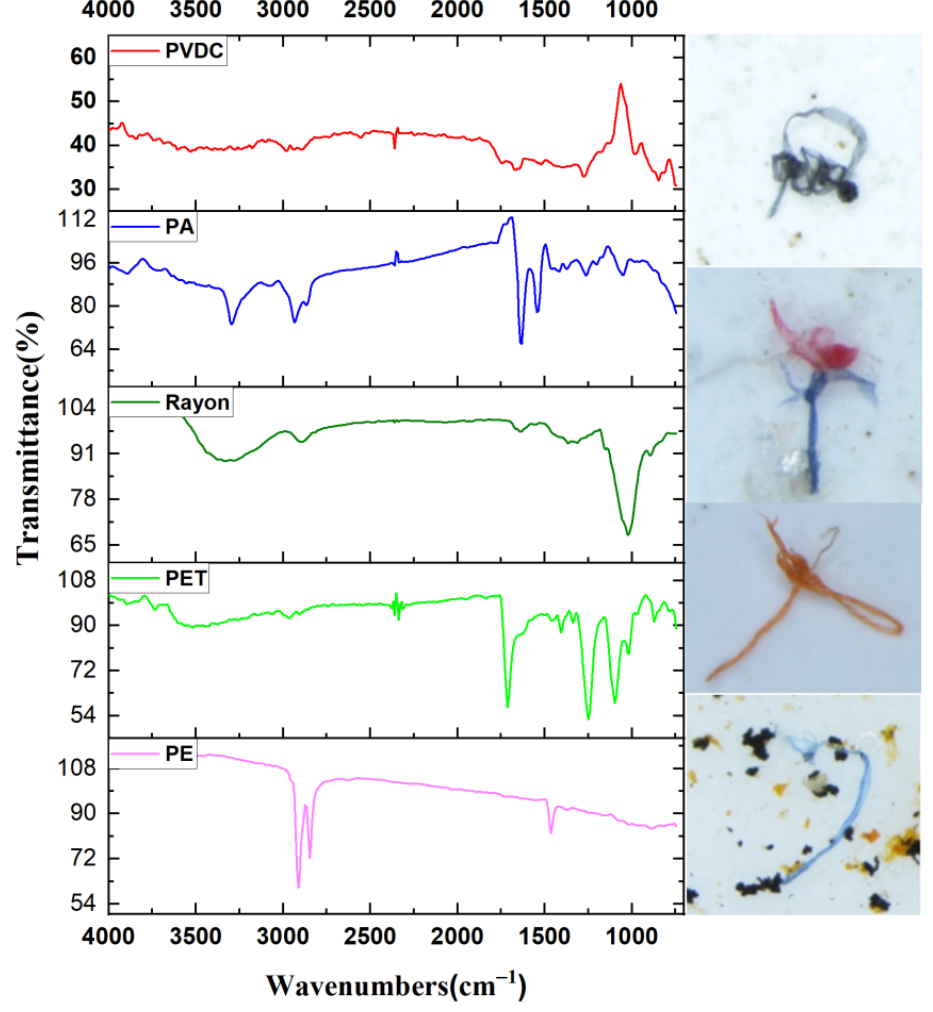
Figure 1. Morphology of microplastics and infrared spectra of microplastics.